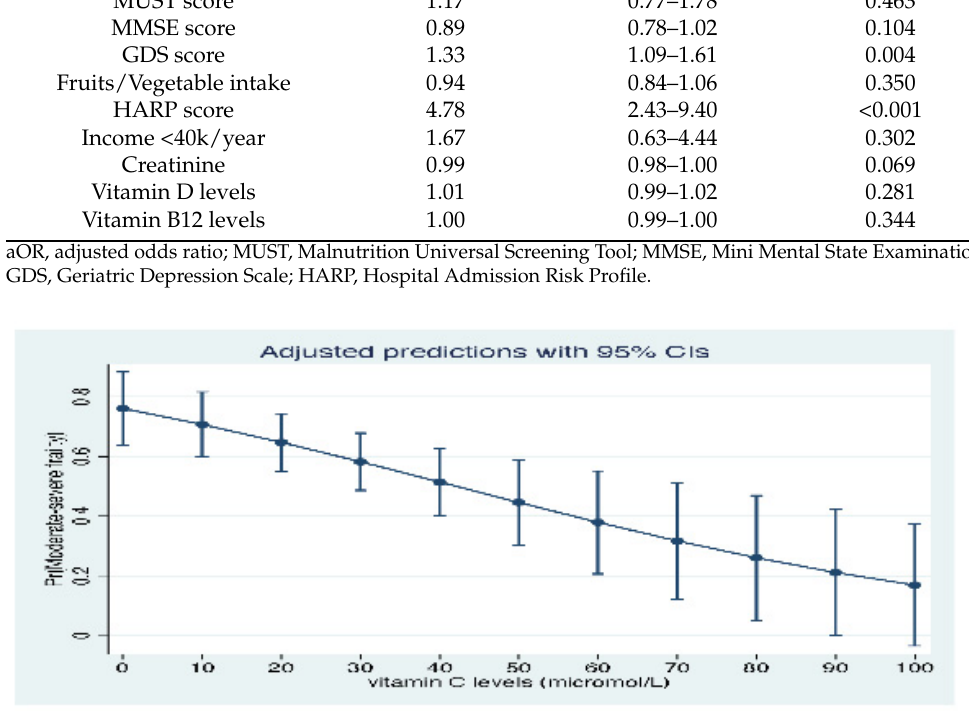
213 Figure 2. Prediction of frailty severity according to vitamin C status. 214 4.